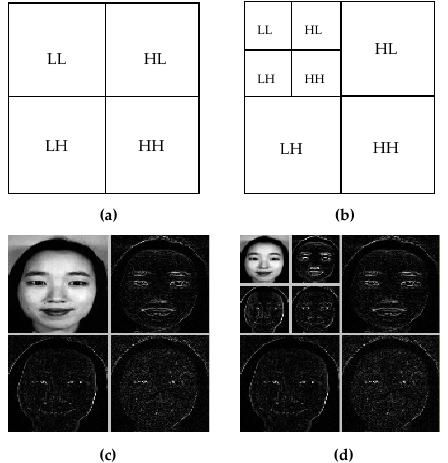
Figure 3. Multilevel wavelet decomposition consists of the following: ( a ) single level components specification, ( b ) two-level components specification, ( c ) discrete wavelet transform (DWT) single level, and ( d ) DWT two-level decomposition. LH—vertical; HL—horizontal; HH—diagonal